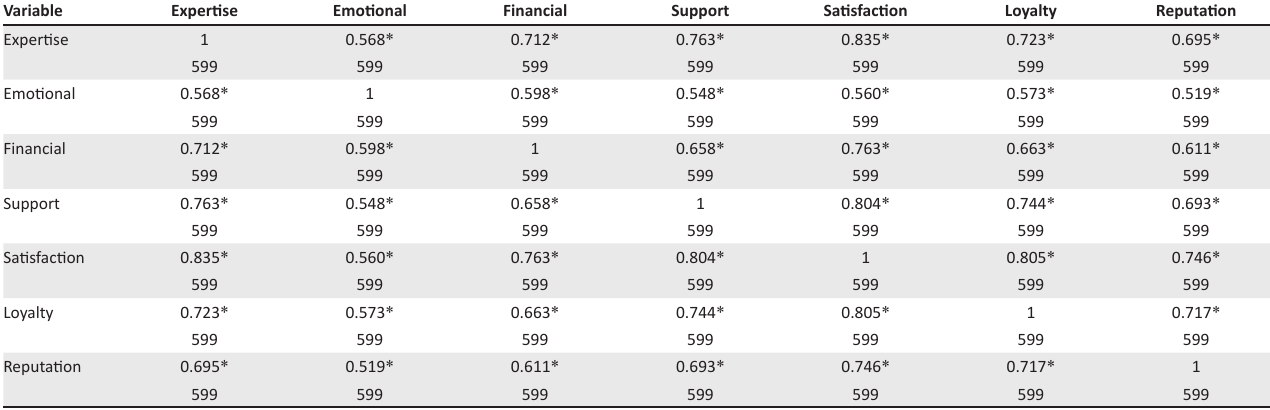
TABLE 7: Correlation matrix of the perceived benefit dimensions and the customer outcome variables. Variable Expertise Emotional Financial